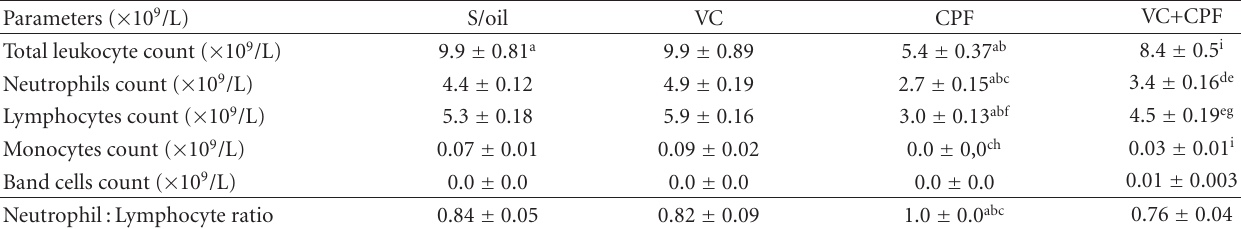
Table 2: E ff ect of chronic exposure to soya oil (S/oil), vitamin C (VC), and/or chlorpyrifos (CPF) on absolute total and di ff erential leukocyte count in Wistar